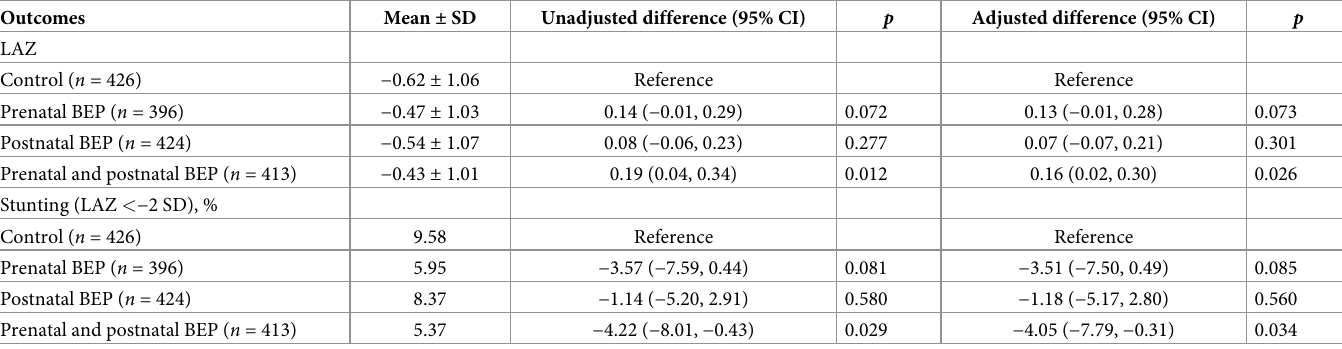
Table 4. Four-arm comparison of the effect of BEP supplementation on linear growth at 6 months 1 .